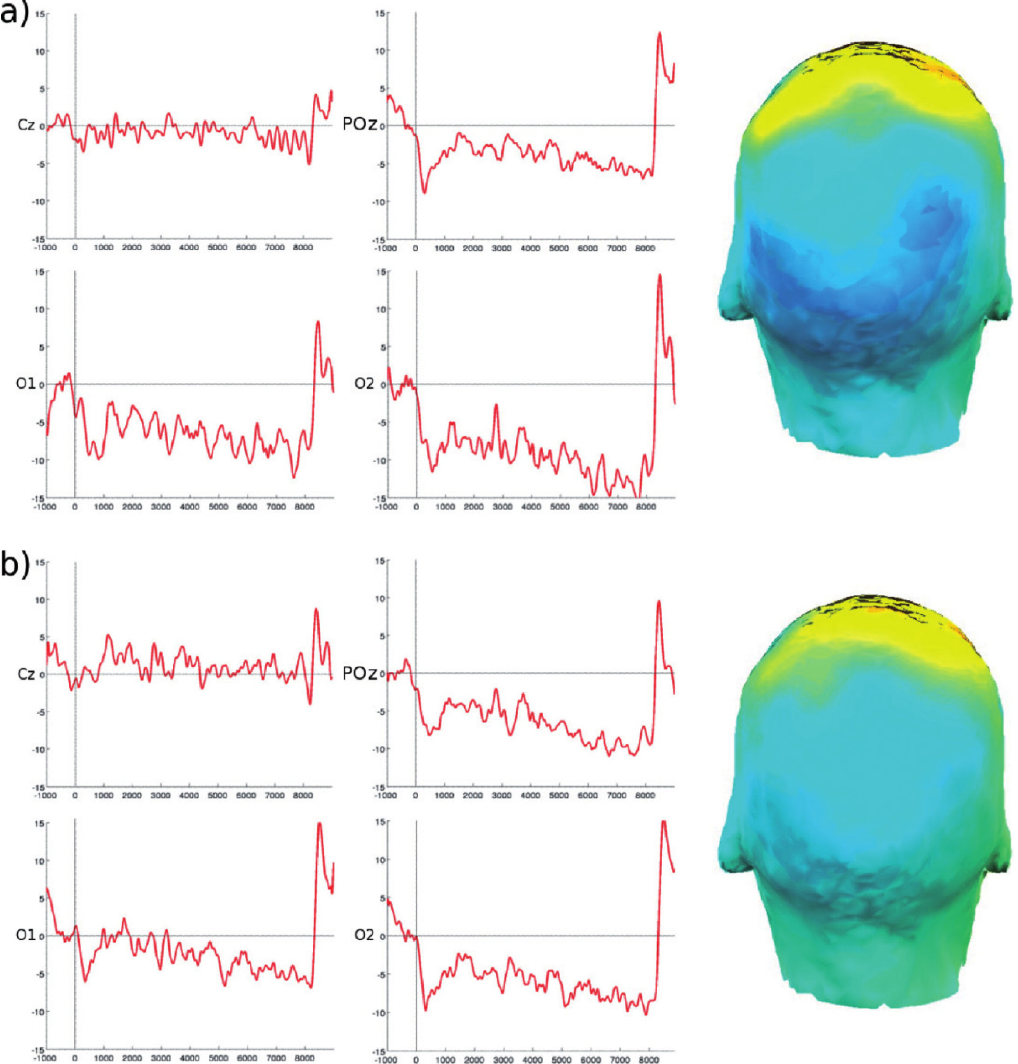
Figure 7. Averaged waveforms at representative scalp locations (left and middle row) and scalp potential topographies (right; dark blue color indicates stronger activation) averaged across the interval from 2,000–5,000 ms post stimulus of a single subject. (a) SCPs recorded inside the scanner without fMRI acquisition, (b) SCPs recorded while acquiring fMRI